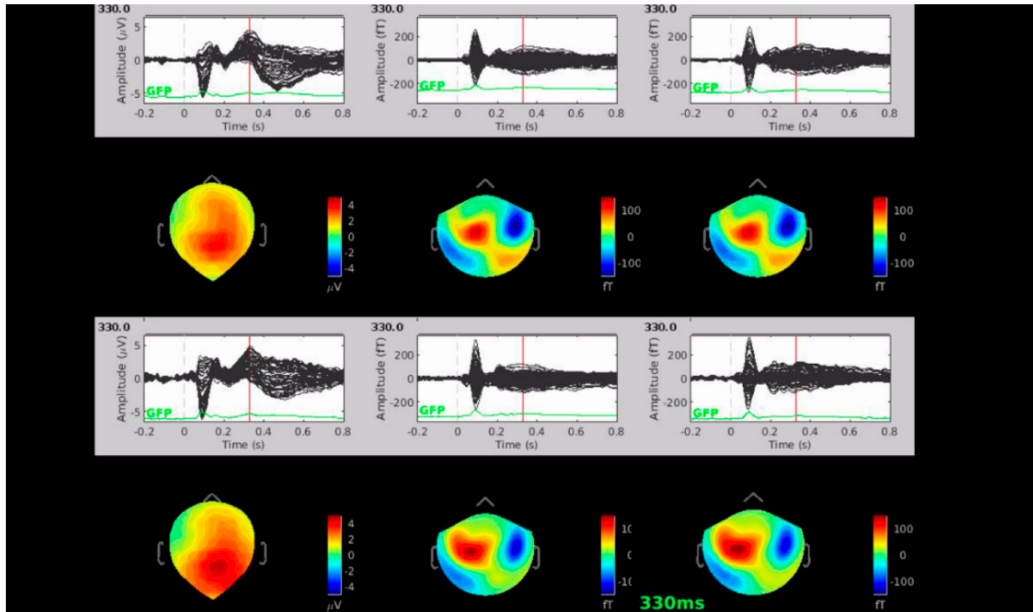
Figure 2. Topographical representation of Grand Average of P300 peak in 16 pwMS (above) and 19 HCs (below). From left to right: EEG-ERP, MEG-magnetometers-ERF, MEG-gradiometers-ERF. No relevant differences of topographical distribution emerged between pwMS and HCs, apart from a slight prevalence of parietal P300 representation in